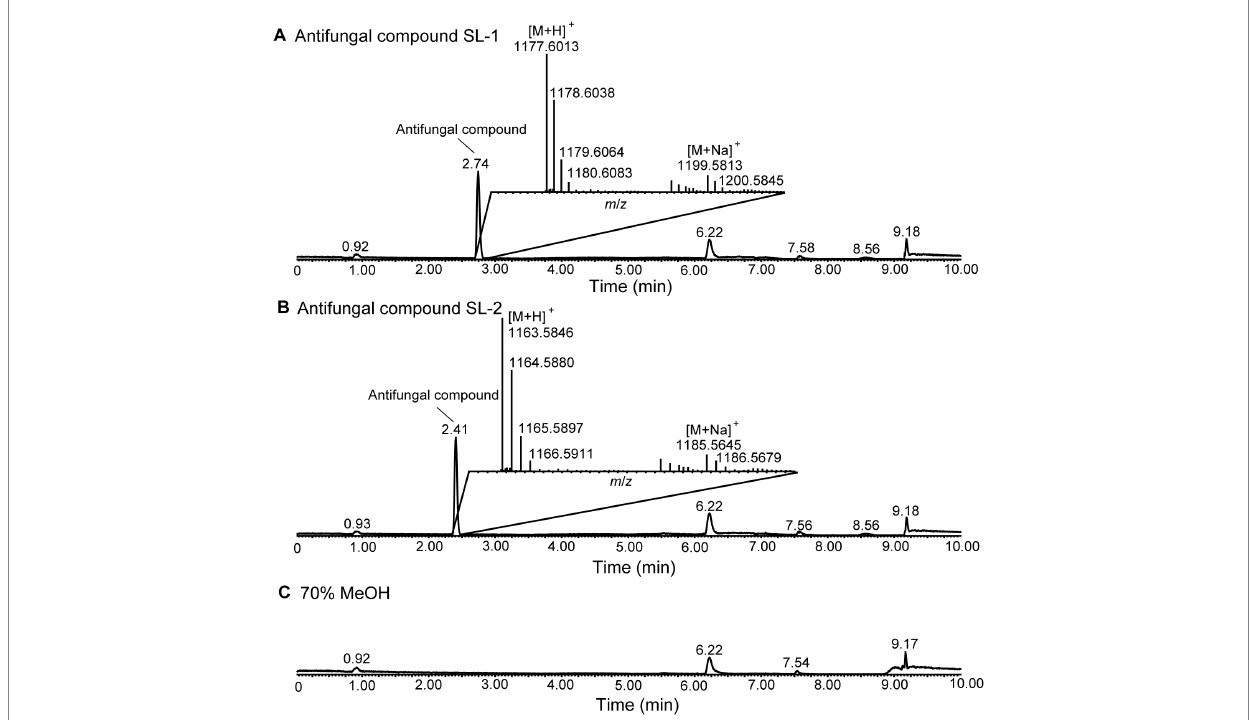
FIGURE 1 LC–MS analysis of the two antifungal compounds produced by strain XY006. (A) Total ion chromatogram (TIC) of the antifungal compounds eluted at 2.74 min. (B) TIC of the antifungal compounds eluted at 2.41 min. The insets show the MS spectra for these two metabolites. (C) TIC of 70% methanol solvent control. The peak labels in the spectrum are observed